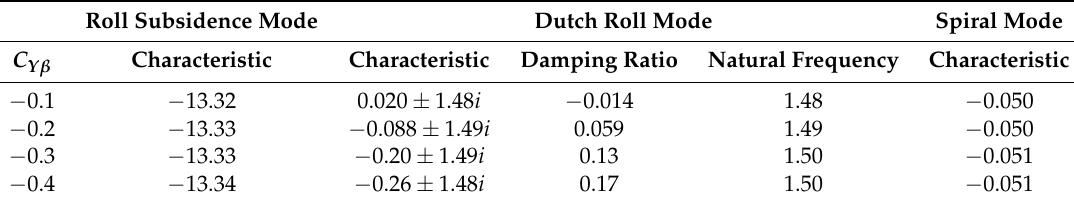
Table 3. The lateral-directional modes of the full-wing drone at different C Y β